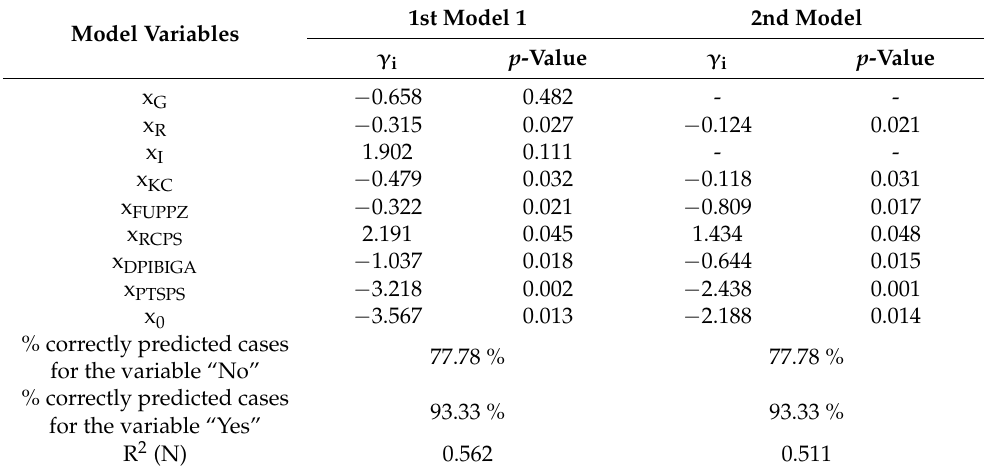
Table 4. Results of the developed logit